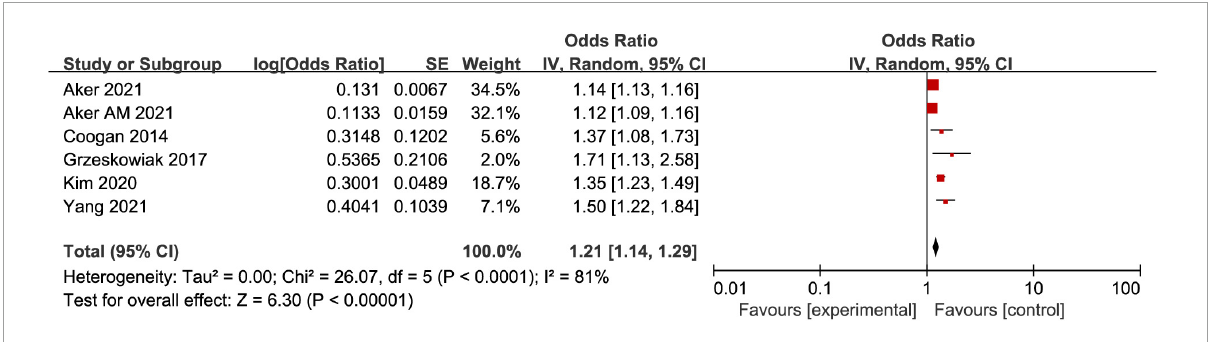
FIGURE2 Forest map of association meta-analysis between AD and MD.